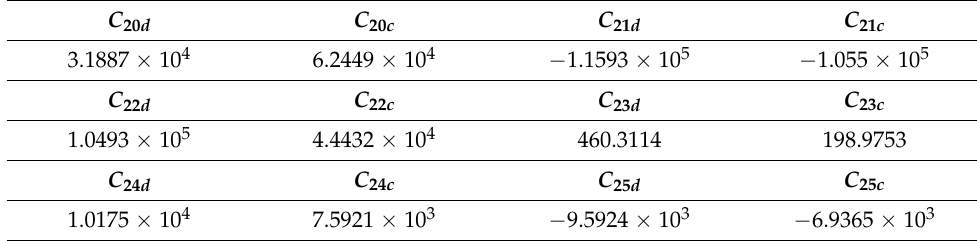
Table A4. Parametric C 1 Function